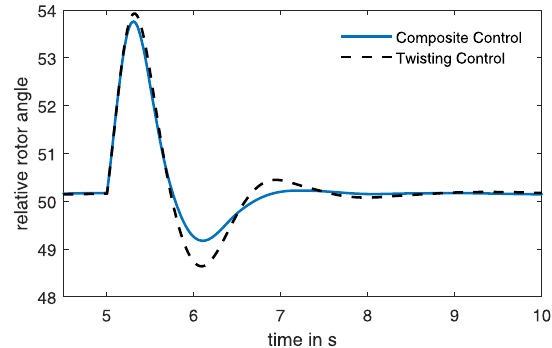
Fig. 12 Terminal voltage variations for load disturbance